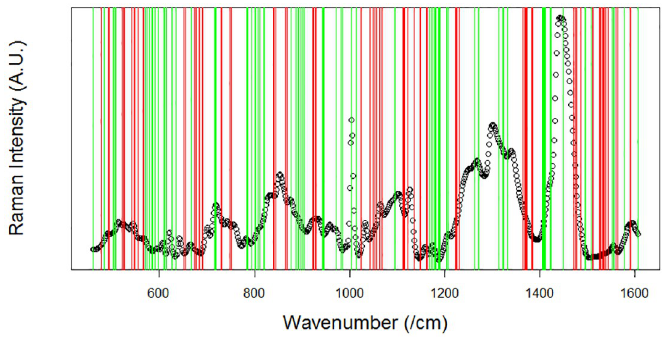
Fig 3. Example of wavenumbers with strong effects in predicting fibrotic grade. These wavenumbers are shown using both red and green lines, with red/green displaying that an increase in intensity results in a decrease/increase in disease likelihood, respectively. White areas are wavenumbers whose coefficients have been reduced to